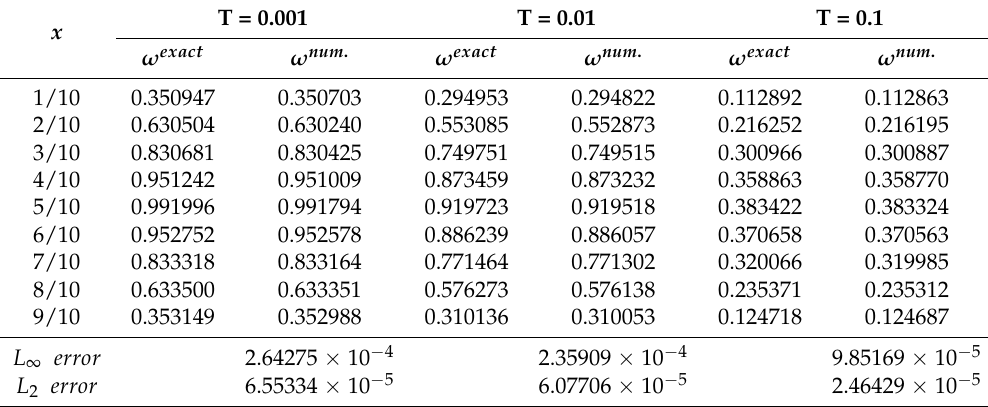
Table 4. Comparison of analytical and numerical results for ∆ x = 0.0125, ν d = 2, and τ = 0.0001 at different value T of the problem 5.2.